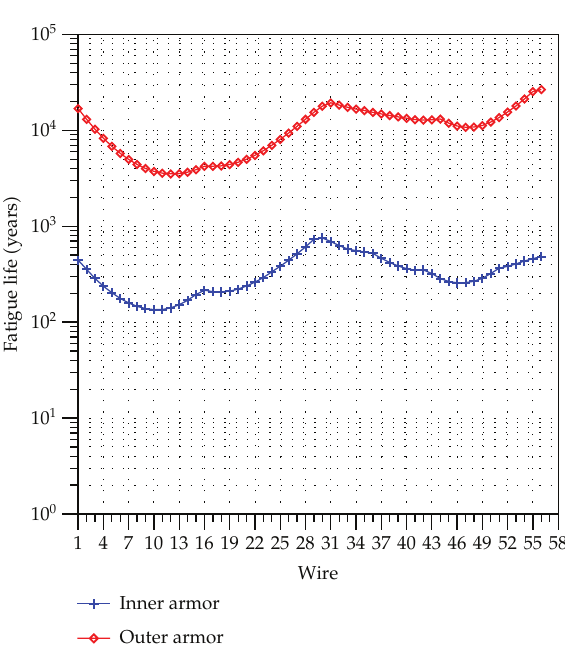
Figure 8: Fatigue life along the critical section: base